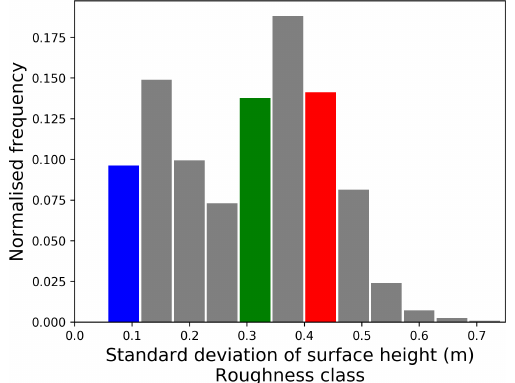
Figure 2. Histogram of the standard deviation of surface heights computed from 70m flight strips; bins define the roughness classes of sea ice. Examples for the three roughness classes “smooth”, “medium rough”, and “rough” are marked in the colours blue, green, and red,